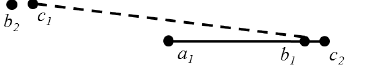
Figure 3. An example of an approximation